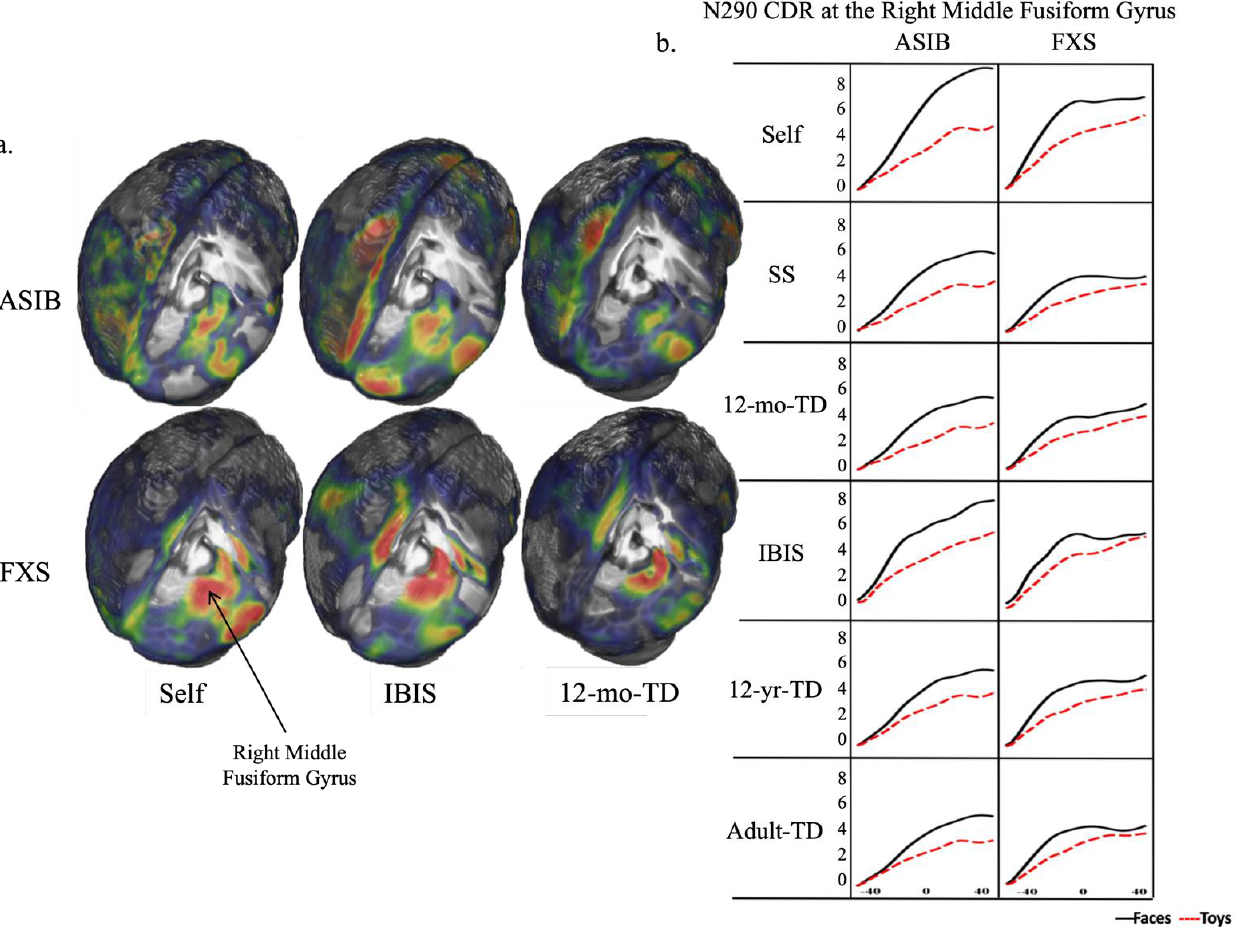
Figure 6. ( a ). Areas and degree of CDR activation are presented on Self, IBIS, and 12-mo-TD whole- head models separately for ASIBs and infants with FXS; warmer colors indicate greater activation; ( b ). Patterns of CDR activation are depicted at the right middle fusiform gyrus during the time window of the N290 separately for ASIBs and infants with FXS for each head model examined.